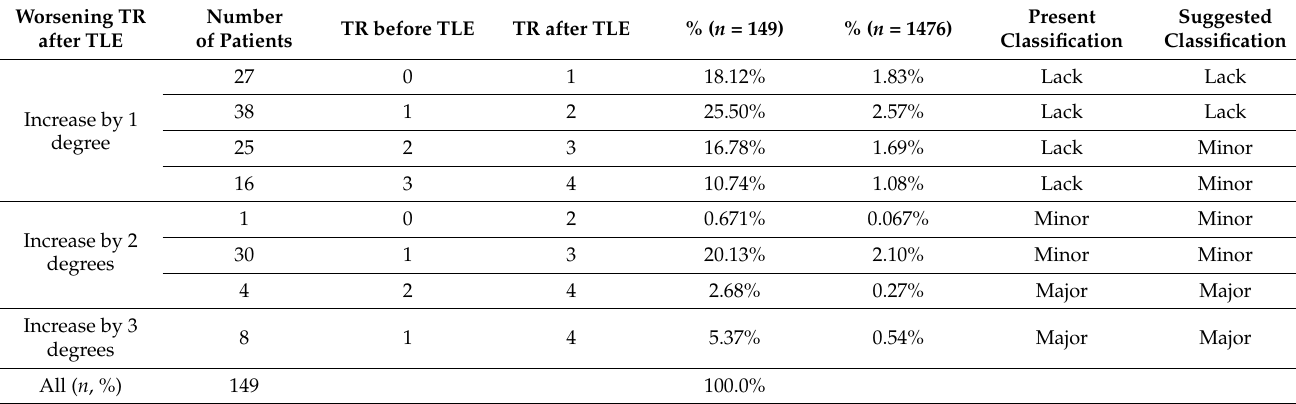
Table 7. Classification of tricuspid regurgitation after